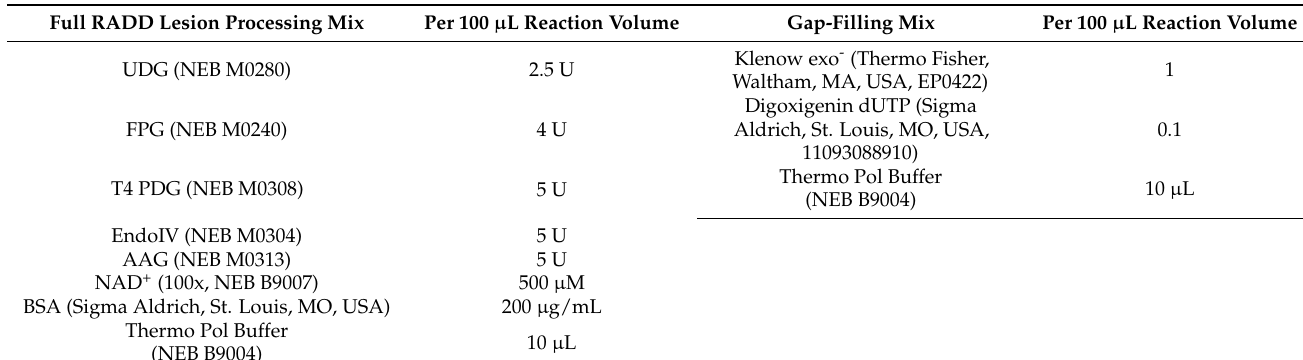
Table 1. RADD reaction conditions. RADD is performed in two sequential reactions without aspirating reagents between reactions. The lesion processing mix (left) is placed on prepared tissues and placed in a humidified incubator. The gap-filling mix (right) is added directly to the lesion processing mix and incubated for an additional hour. The reagents are then aspirated, and the cells are washed and incubated with anti-digoxigenin antibody.